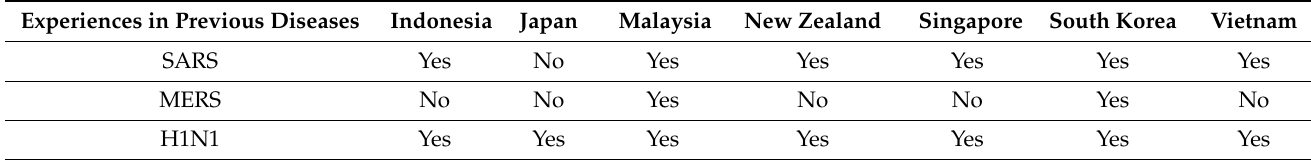
Table 7. Countries’ past experiences in handling